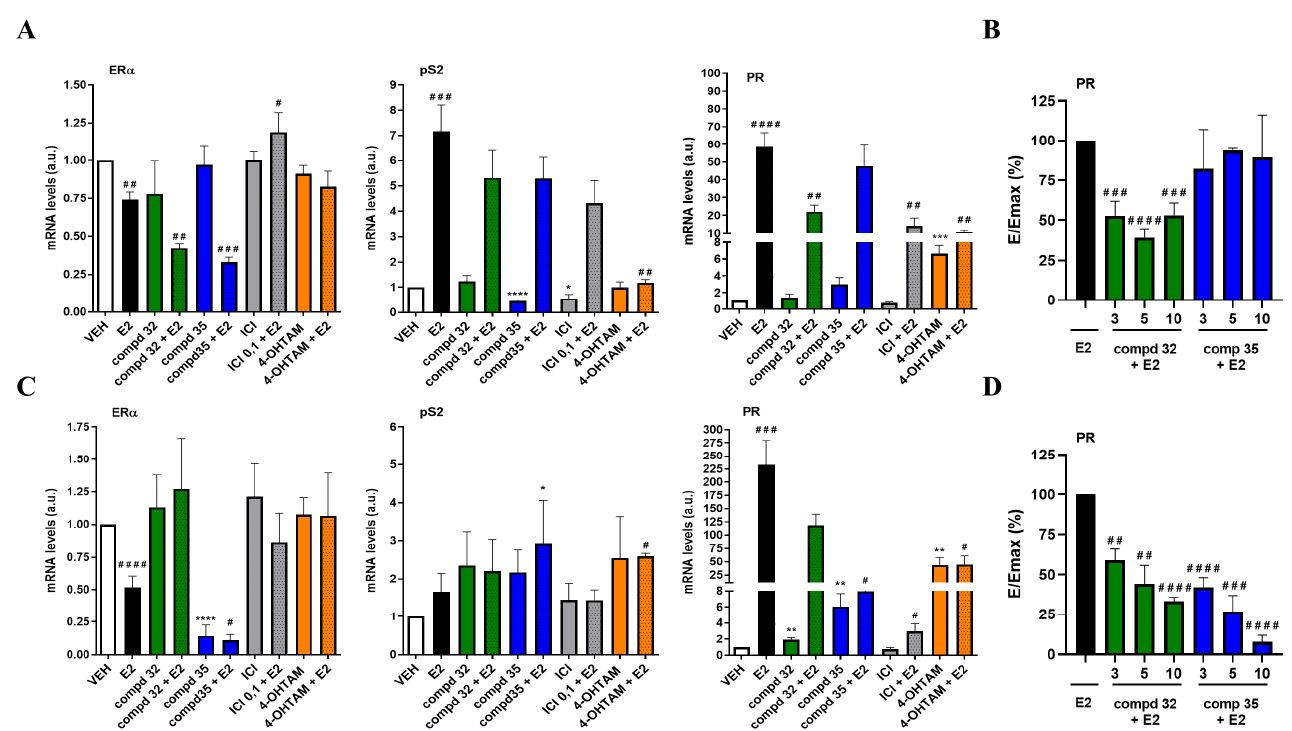
Figure 9. 5-Hydroxy-2 H -pyrrol-2-ones 32 and 35 exhibit antiestrogenic effects on E2-induced gene expression in human ER+ breast and endometrial cancer cells. ER α , pS2 and PR mRNA gene expression were analyzed by quantitative real-time PCR (q-RT-PCR) using 18S as a housekeeping gene in E2-depleted MCF-7 or Ishikawa cells. Cells were pretreated with compounds 32 , 35 , ICI or 4- OHTAM for 3 h, before the addition of vehicle (VEH; 0.05% DMSO) or E2 (10 nM) for 24 h. ( A ) MCF- 7 and ( C ) Ishikawa cells were treated with compounds 32 (5 µM), 35 (10 µM), ICI (0.1 µM) or 4- OHTAM (1 µM) in the absence (+VEH) and presence of E2. Graphs represent relative mRNA levels